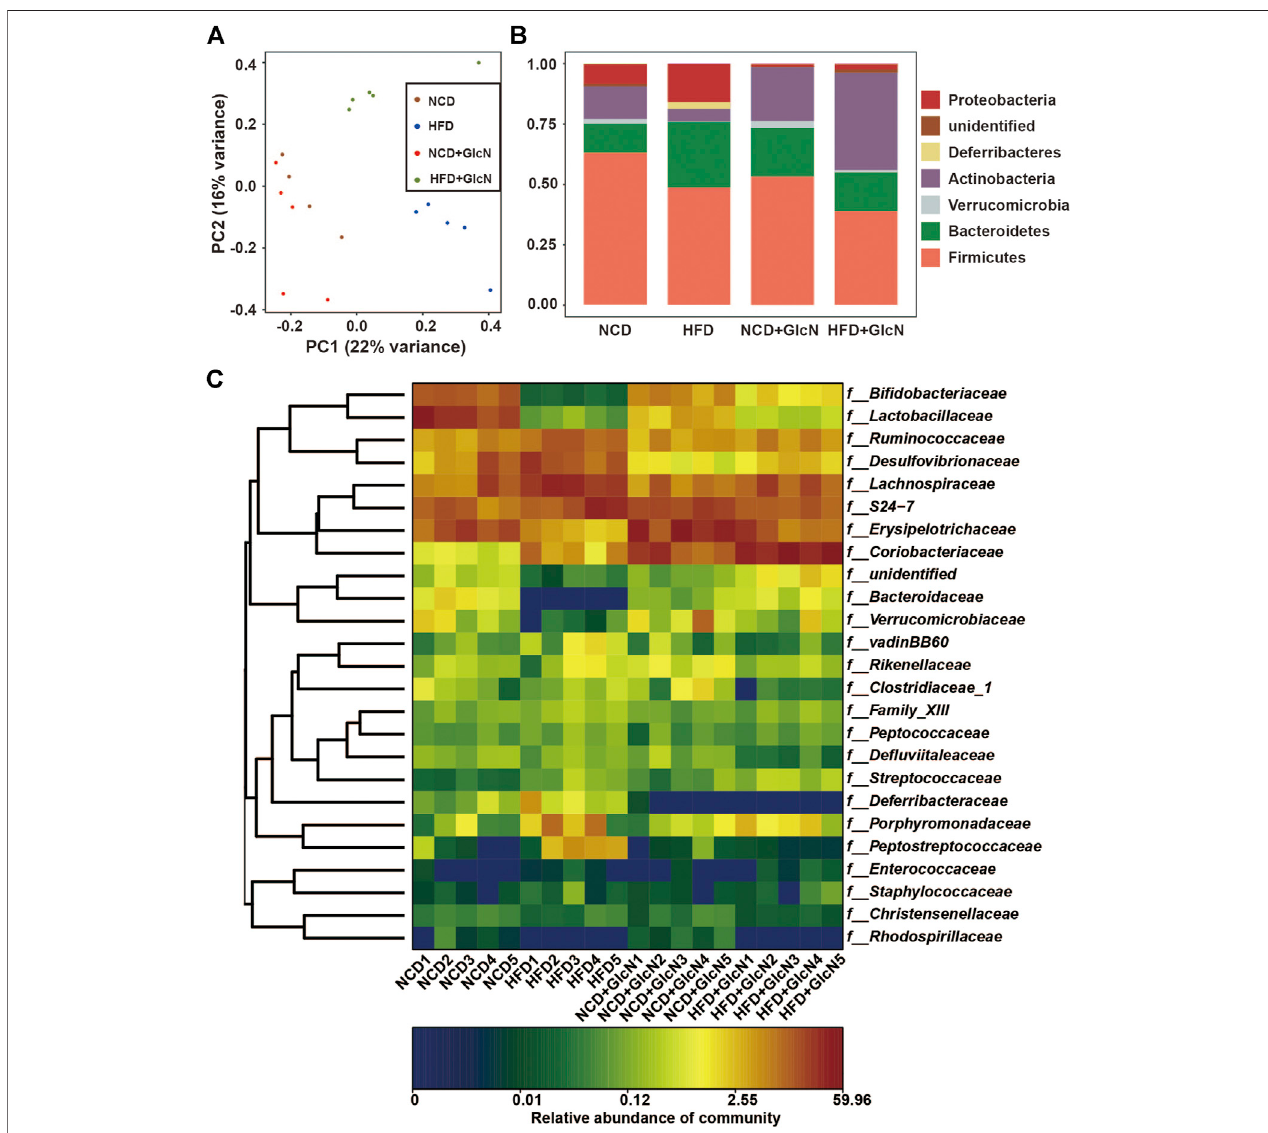
FIGURE3 | Effect of GlcN treatment on gutmicrobiota composition ofHFD-fed mice. Afterthe treatmentwith NCD, HFD, and/or GlcN (1 mg/ml, in drinking water) for 5 months, all mice were sacri fi ced and the cecal contents were collected for 16S rDNA sequencing. The differences in gut microbial diversity and abundance among four experimental groups were shown by Principal Component Analysis (PCA) (A) , histogram of phylum level (B ), and heatmap of genus level (C) .